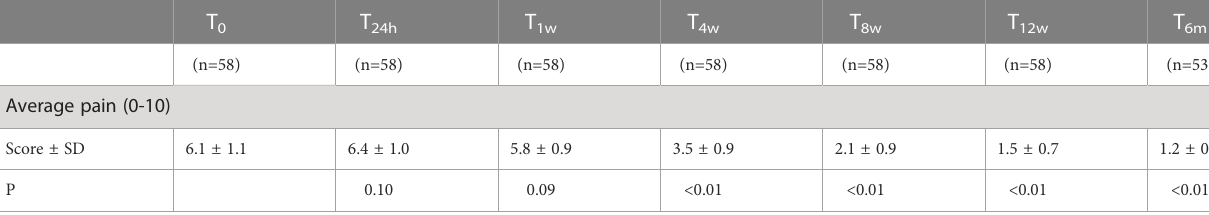
TABLE 2 The NRS pain scores in each treatment period and distribution of pain severity